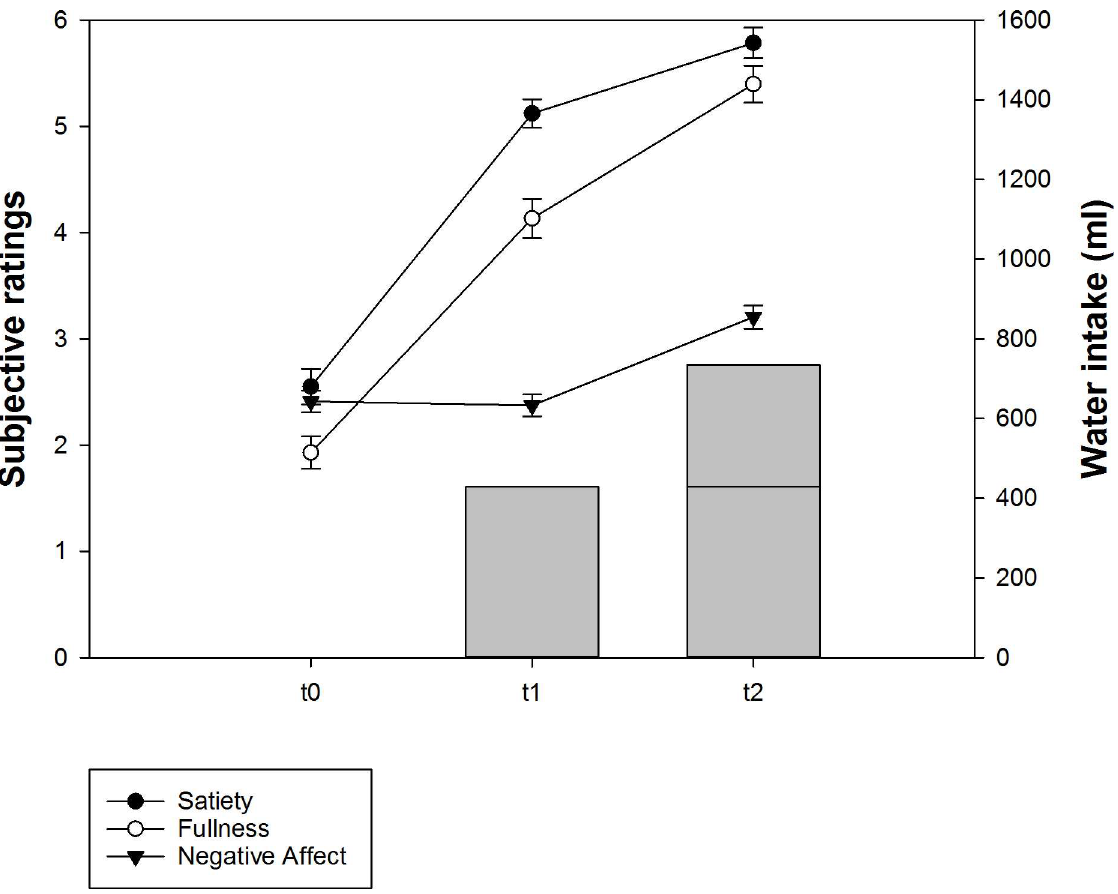
Fig 1. Mean ( ± SE) subjective sensations related to the WLT-II and ingested water volumes at t0, t1, and